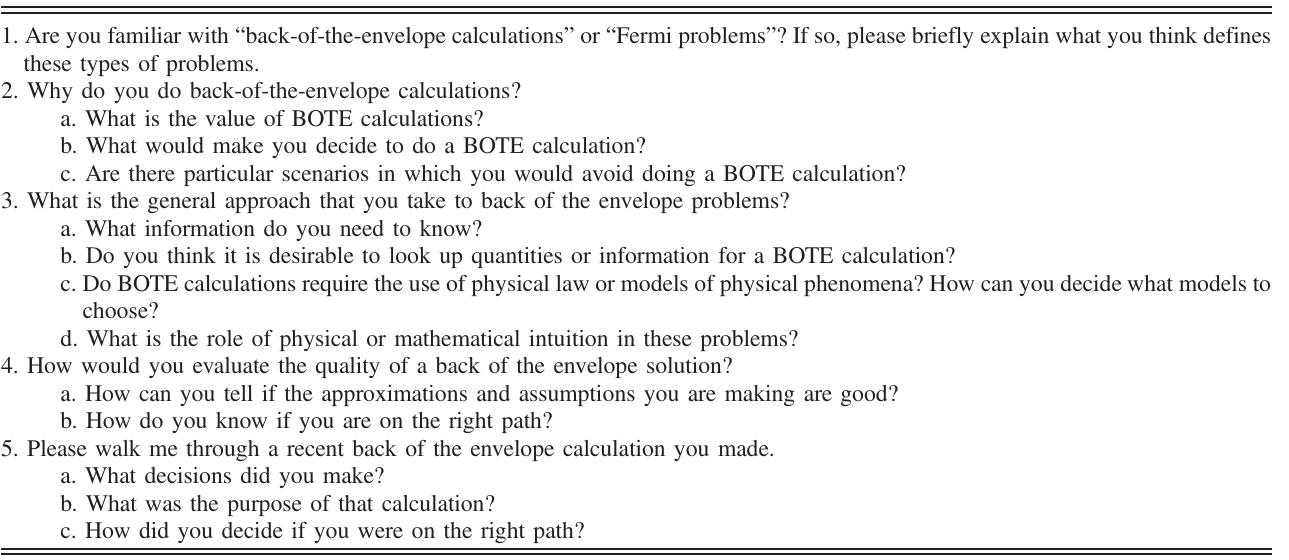
TABLE II. Interview